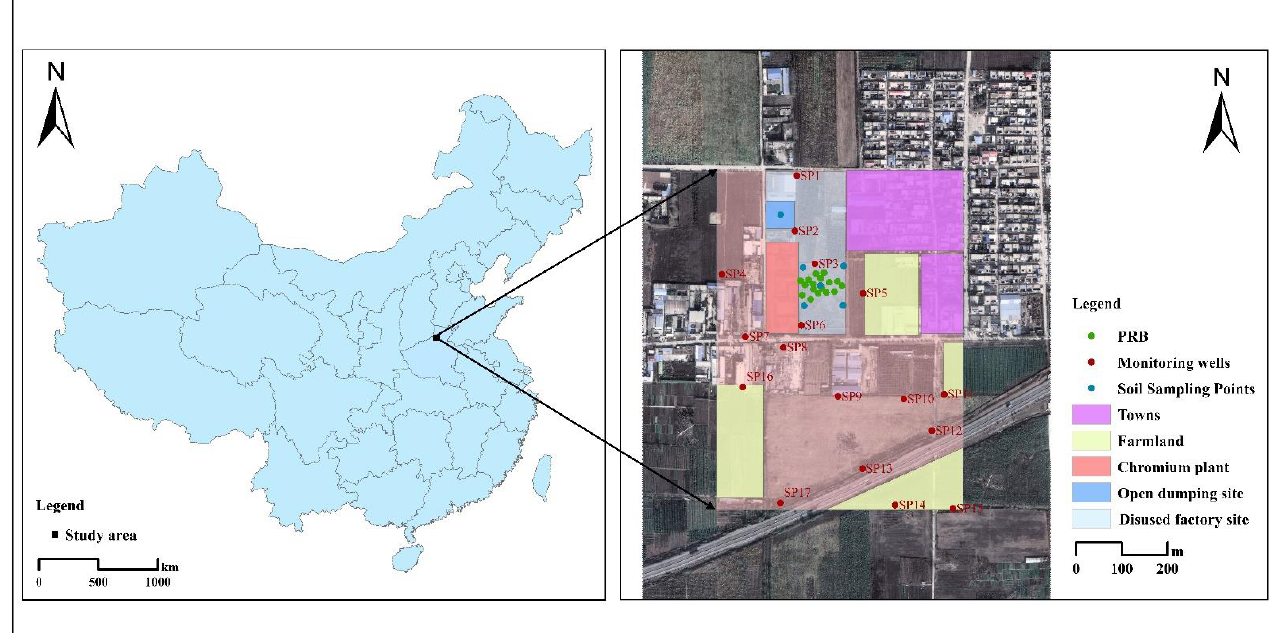
Figure 1. Location map of the study area and groundwater sampling locations.